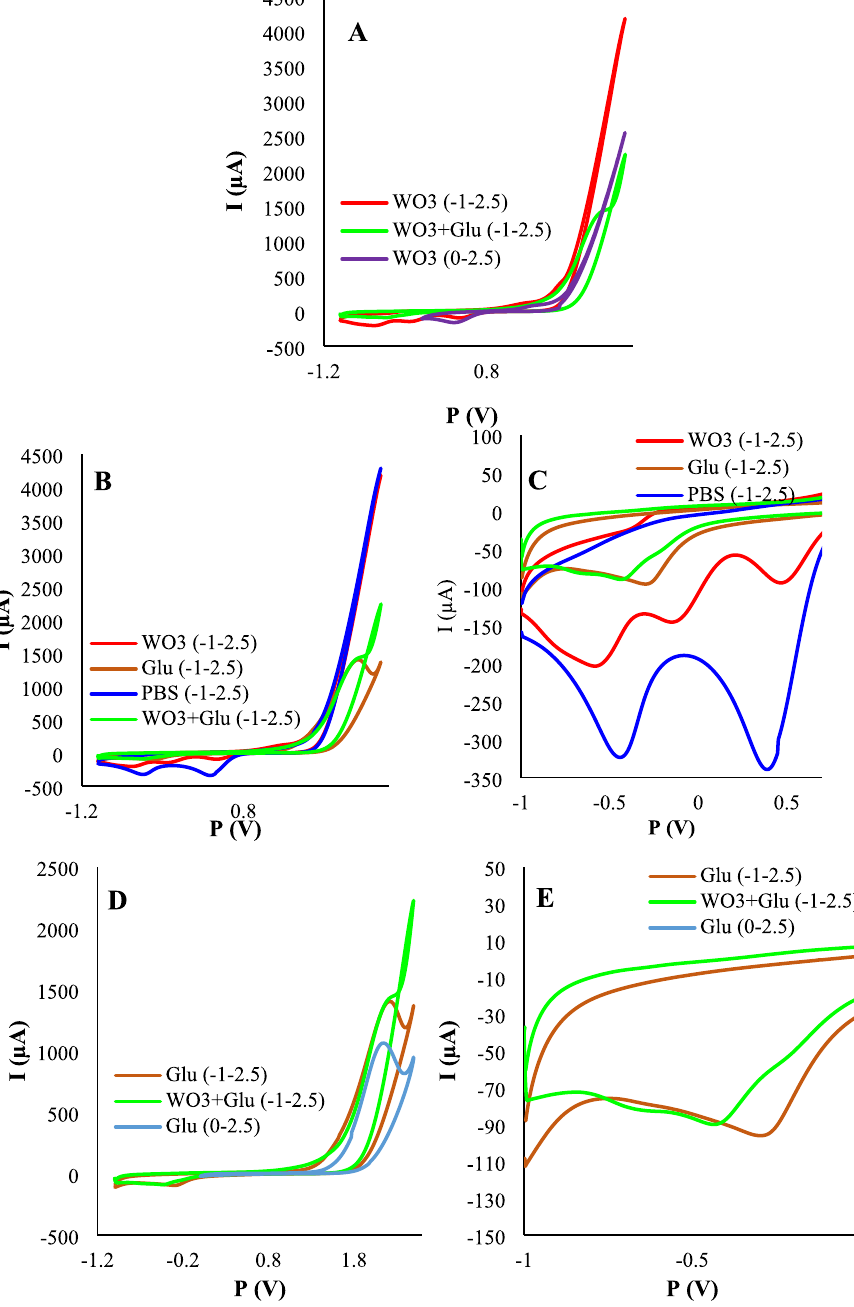
Figure 2. The electrochemical evaluation of the electrosynthesis methodology of WO 3 /p-Glu. ( A) assessment of WO x electrosynthesis in two different potential ranges (− 1 to 2.5 V and 0–2.5 V) and precursor compositions; ( B ) representative illustration of the composition effect of precursor on the shape, position, and intensity of the electrochemical peaks (all measurements proceeded in that range of – 1 to 2.5 V); ( C ) magnified image of panel ( B ); ( D ) investigation of p-Glu electrosynthesis in two different potential ranges (− 1 to 2.5 V and 0–2.5 V) and precursor compositions (glutamic acid, WO 3 /glutamic acid); ( E ) magnified image of panel ( D ). All the solutions were prepared in PBS (0.1 M, pH = 7.4). All the measurements were progressed in the scan rate of 0.1 V/s. The electrochemical measurements were obtained in a PBS buffer (pH = 7.4) of 5 mM K 4 [Fe(CN) 6 ] and 0.1 M